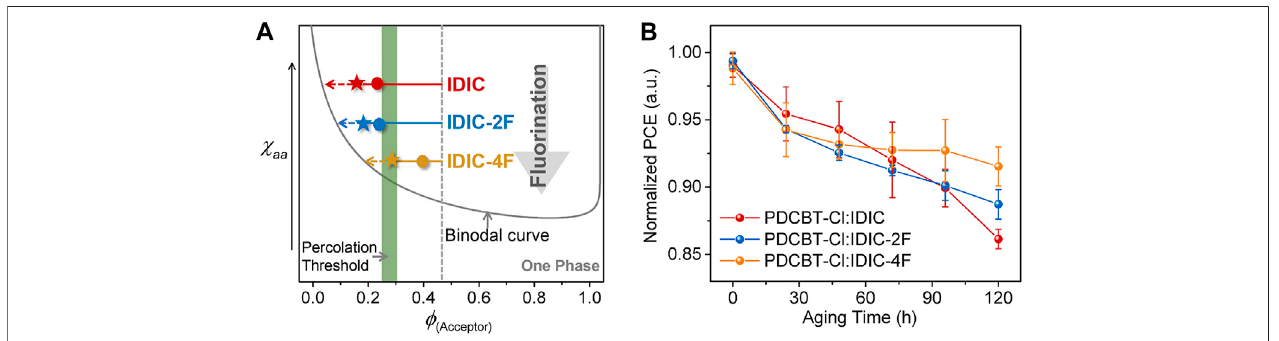
FIGURE7|(A) Illustrationoftheamorphous χ aa - ϕ s phasediagrambasedonPDCBT-Cl:IDIC-xFblends.Thedotsandpentaclesrepresentthestatesoftheas-cast fi lms and SVA (60s)-treated fi lms, respectively. The arrows indicate the evolution of the compositions for the mixed domains during the SVA and aging process. (B) Normalized PCE vs. continuous aging time for PDCBT-Cl:IDIC-xF based devices. The error bars represent standard deviations of at least eight devices for each